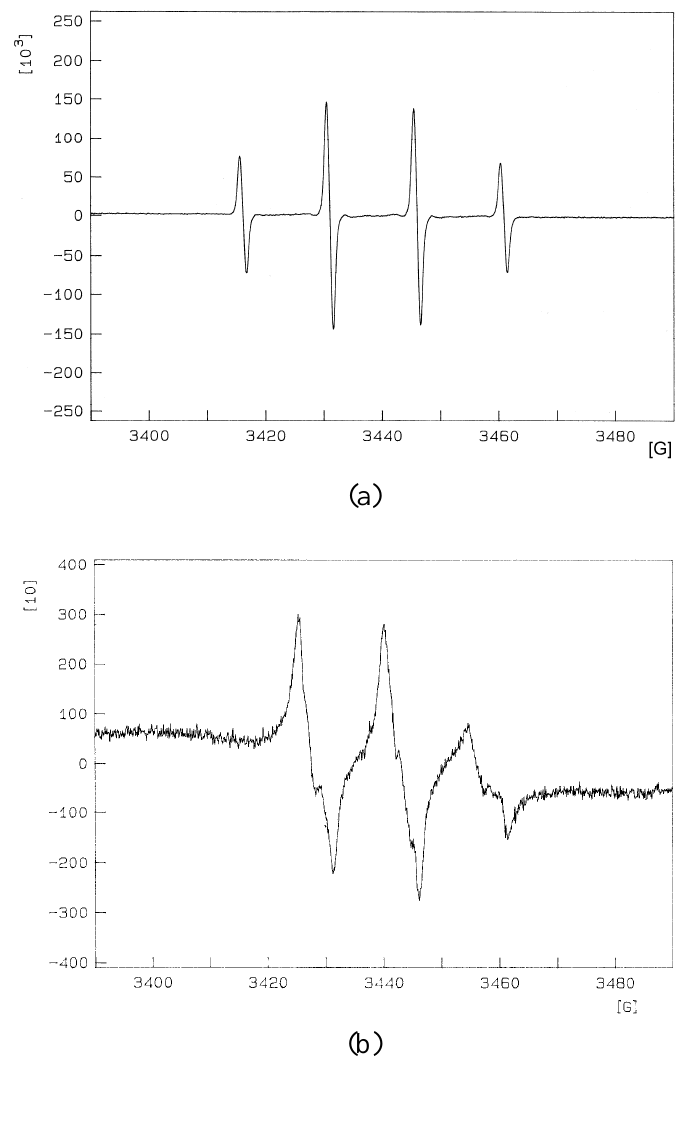
Figure 2. ESR spectra of a) DMPO-OH spin adduct obtained by Fenton reaction, b) PBN-OOL spin adduct formed during ACVA-induced peroxidation of sunflower oil and c) PBN-OOL spin adduct formed during AAPH-induced peroxidation of